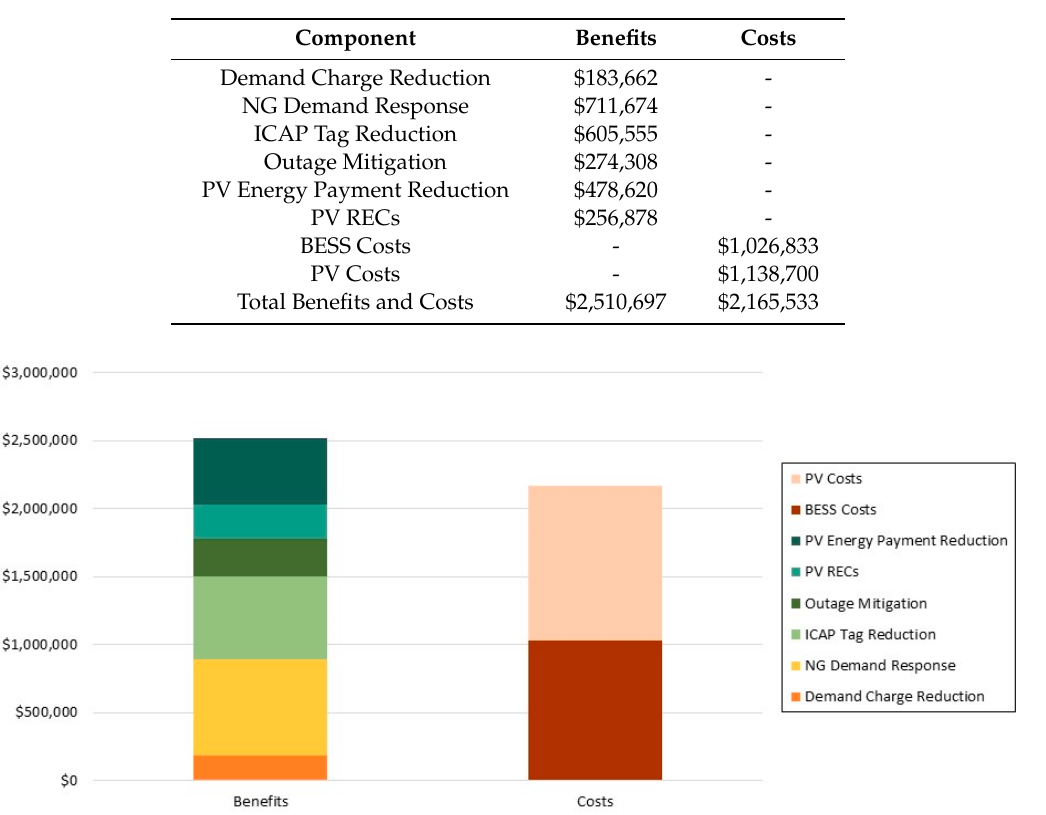
Table 6. Northampton microgrid 20-year present value benefits vs. costs.